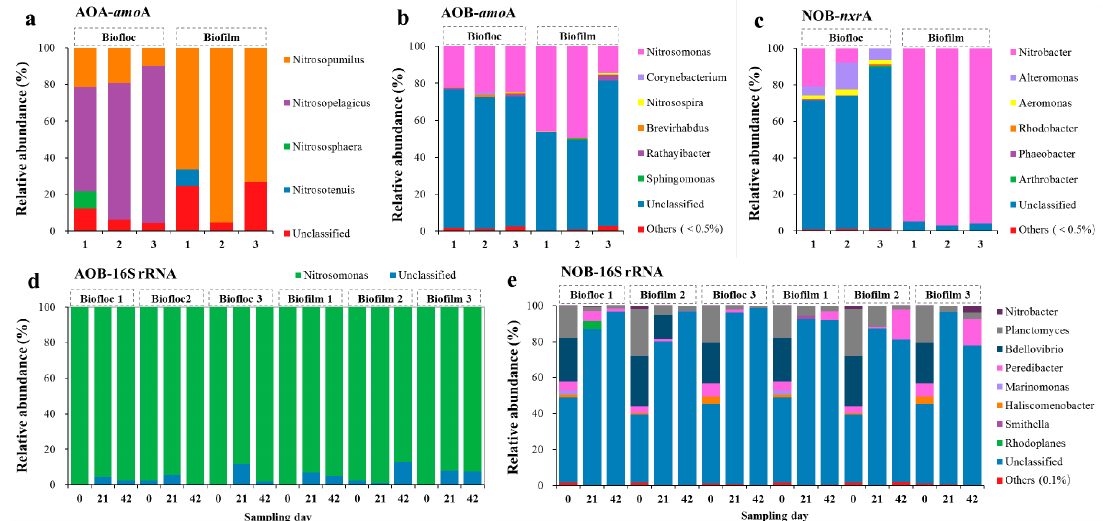
Figure 6. Genus-level composition of nitrifying microbial communities based on Miseq sequencing of 16S rRNA and functional genes in biofloc and biofilm from the biofloc-RAS for shrimp intensive culture in a 70-day trial. ( a ) Relative abundance of AOA- amo A at day 42; ( b ) Relative abundance of AOB- amo A at day 42; ( c ) Relative abundance of NOB- nxr A at day 42; ( d ) Relative abundance of AOB-16S rRNA at day 0, 21 and 42; ( e ) Relative abundance of NOB-16S rRNA at day 0, 21 and 42. For those dominant genera of AOA, AOB, and NOB involving corresponding nitrogen